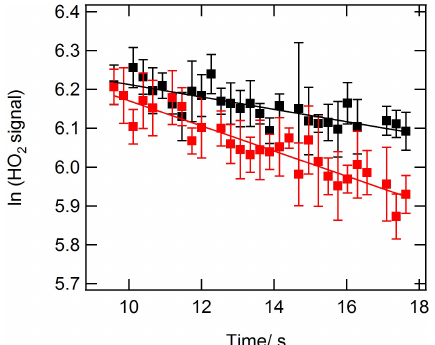
Figure 3. Examples of the HO 2 wall loss without any aerosol particles along the flow tube (black squares) and the HO 2 loss with an aerosol surface area of 2.2 × 10 − 4 cm 2 cm − 3 for TMB- derived aerosol particles at an initial HO 2 concentration of ∼ 1 × 10 9 moleculecm − 3 (red squares) and for RH = 50%. The er- ror bars represent 1 standard deviation in the measured HO 2 signal for a measurement time per point of